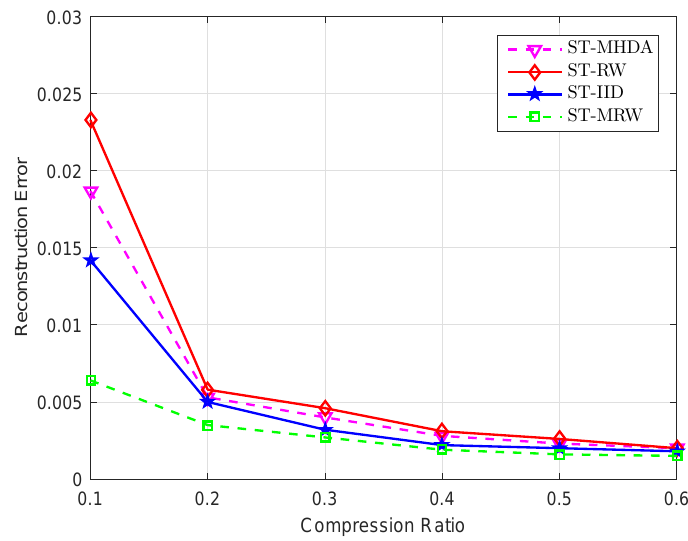
Figure 9. The reconstruction error for spatial-temporal data collection with different CS-based schemes.